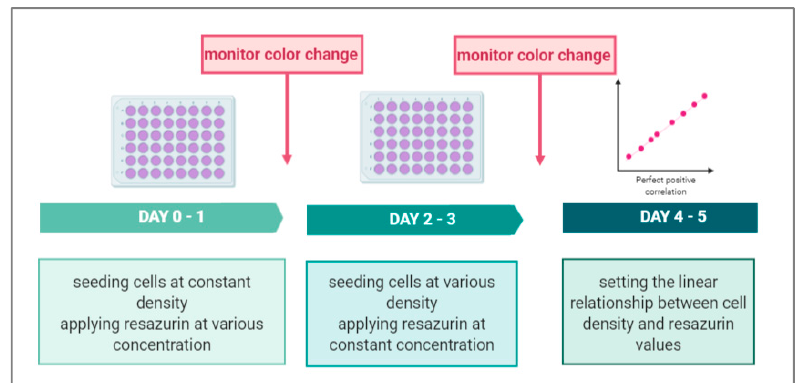
Figure 1. Generalized scheme representing an optimization protocol of a resazurin-based assay for the determination of cancer cell numbers.